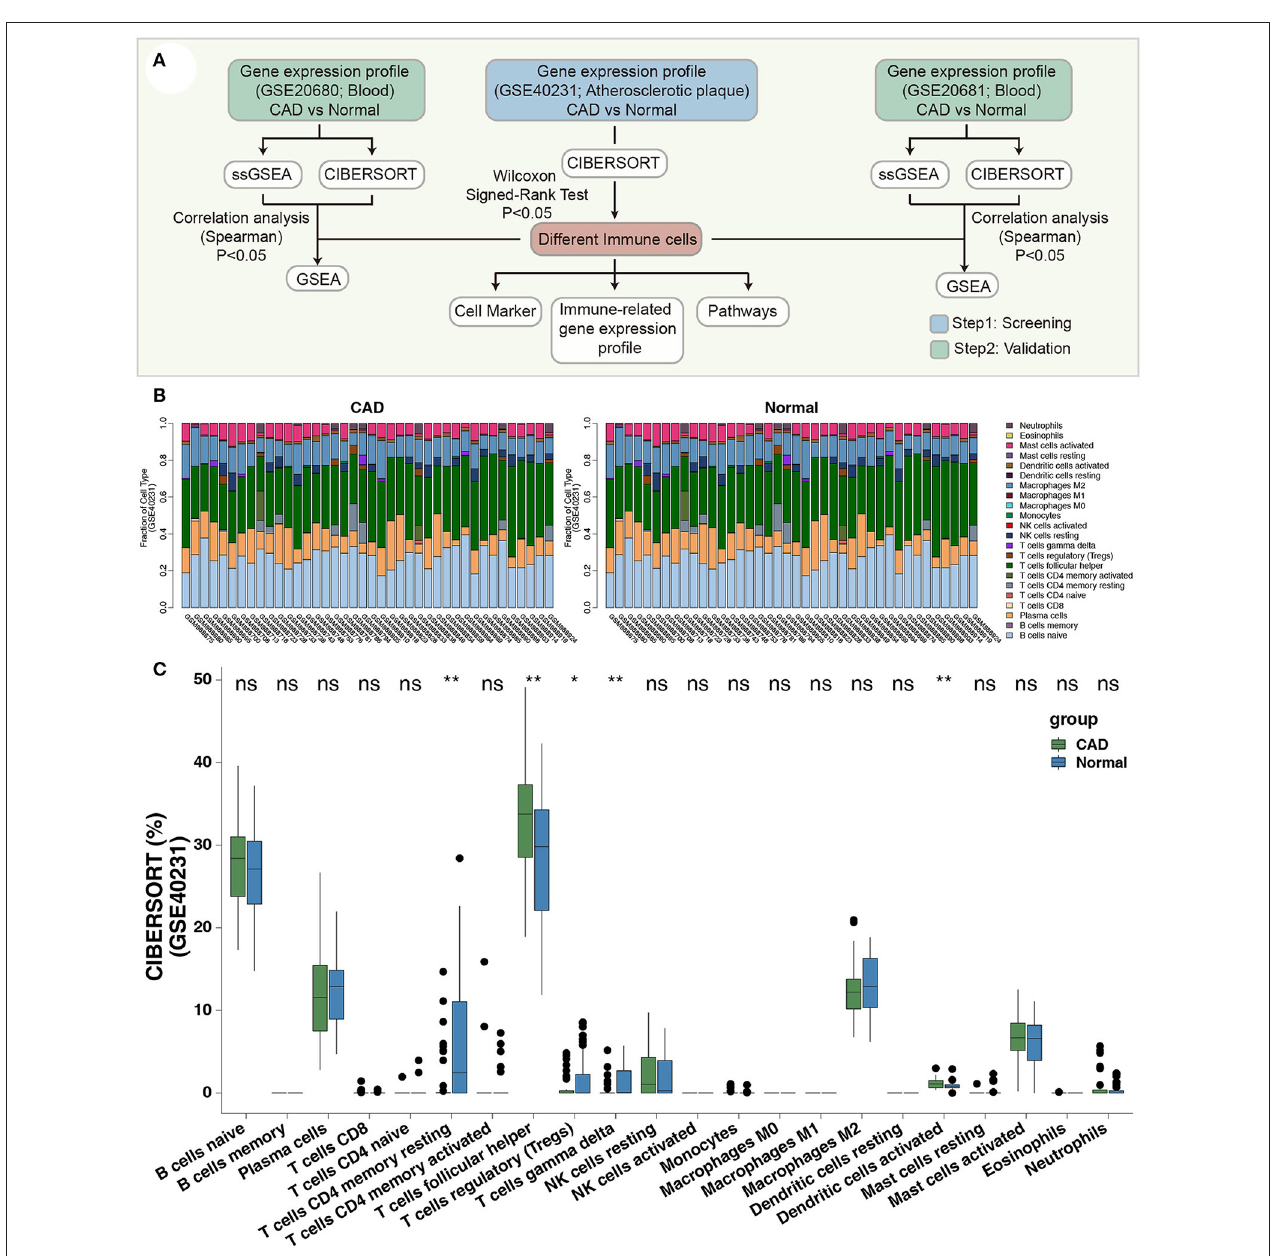
FIGURE 1 | (A) The workflow of the present study. (B) The bar plot indicates the proportions of the 22 immune cells of each sample in GSE40231. (C) The proportions of immune cells of the CAD cases vs. the healthy controls in GSE40231 using CIBERSORT analysis. Wilcoxon signed-rank test (paired): ** P < 0.01; * P < 0.05. CAD, coronary artery